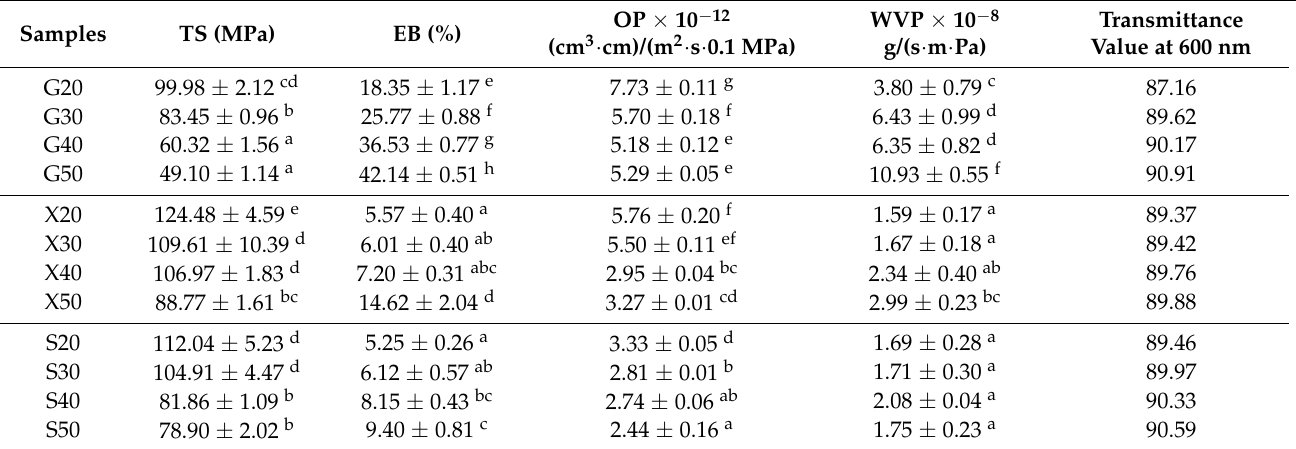
Table 1. Data summary table (TS, EB, OP, WVP, and Transmittance